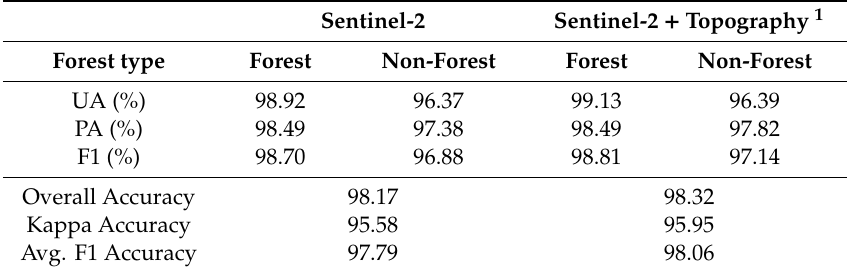
Table 2. The summary of the accuracy assessment for the forest / non-forest classification.